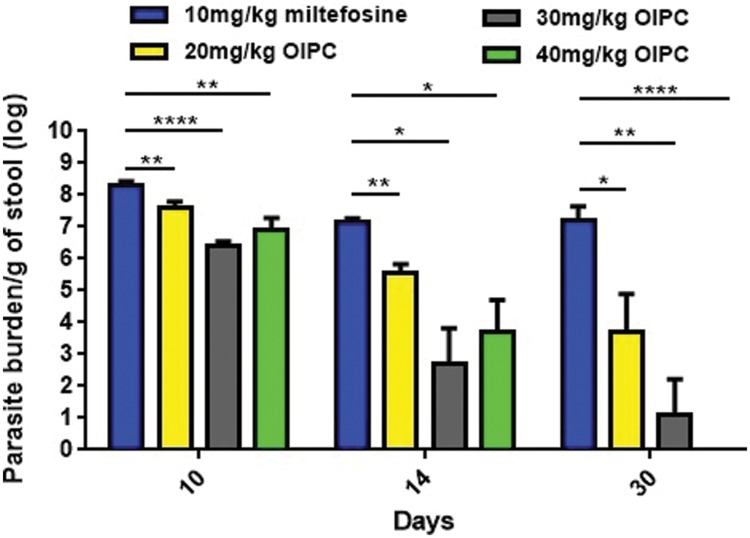
Oocyst shedding in C57BL/6 IFNγR-KO mice infected with C. parvum. All stool samples were collected from individual mice within each group, processed and analyzed by qPCR. Results were normalized to shed oocysts per grams of stool. Error bars were calculated as ±SEM (∗P < 0.05, ∗∗P < 0.01, and ∗∗∗∗P < 0.0001).